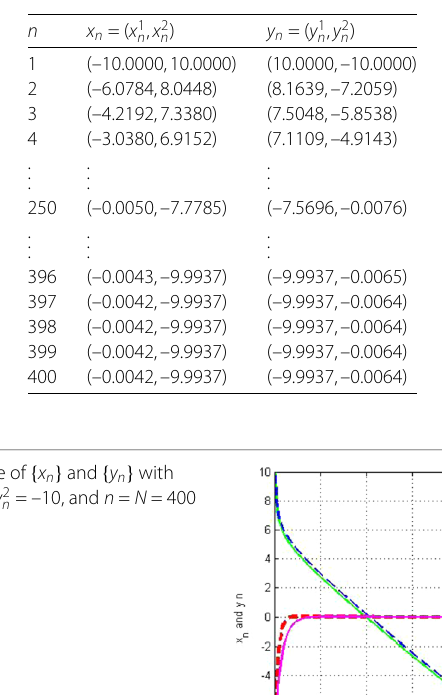
Table 1 The values of { x n } and { y n } with x 1 n = –10, x 2 n = 10, y 1 n = 10, y 2 n = –10, and n = N = 400